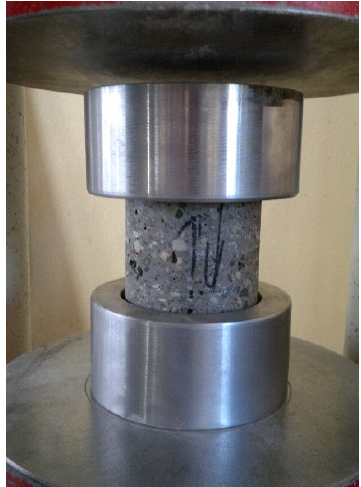
Figure 4. Core sample during the compressive strength test in the strength testing machine.